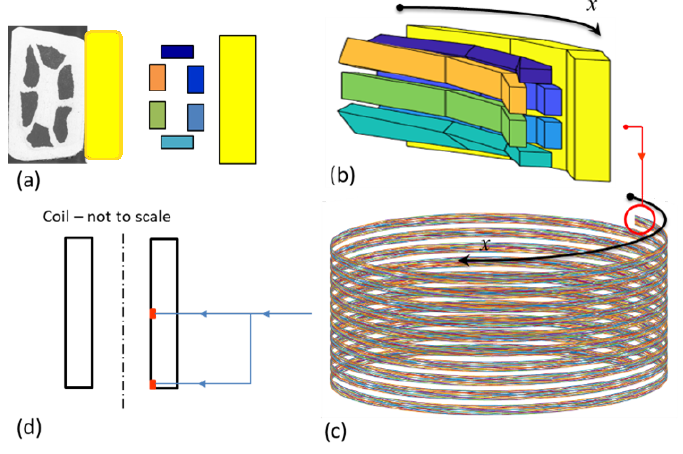
Figure 4. ( a ) Micrography and 2D geometrical model of the MgB 2 filaments and the copper strip. ( b ) 3D geometrical of a short conductor’s length. ( c ) Geometrical model of 10 turns. ( d ) Two considered positions (at the middle and the bottom of the innermost layer) of the 10 turns within the